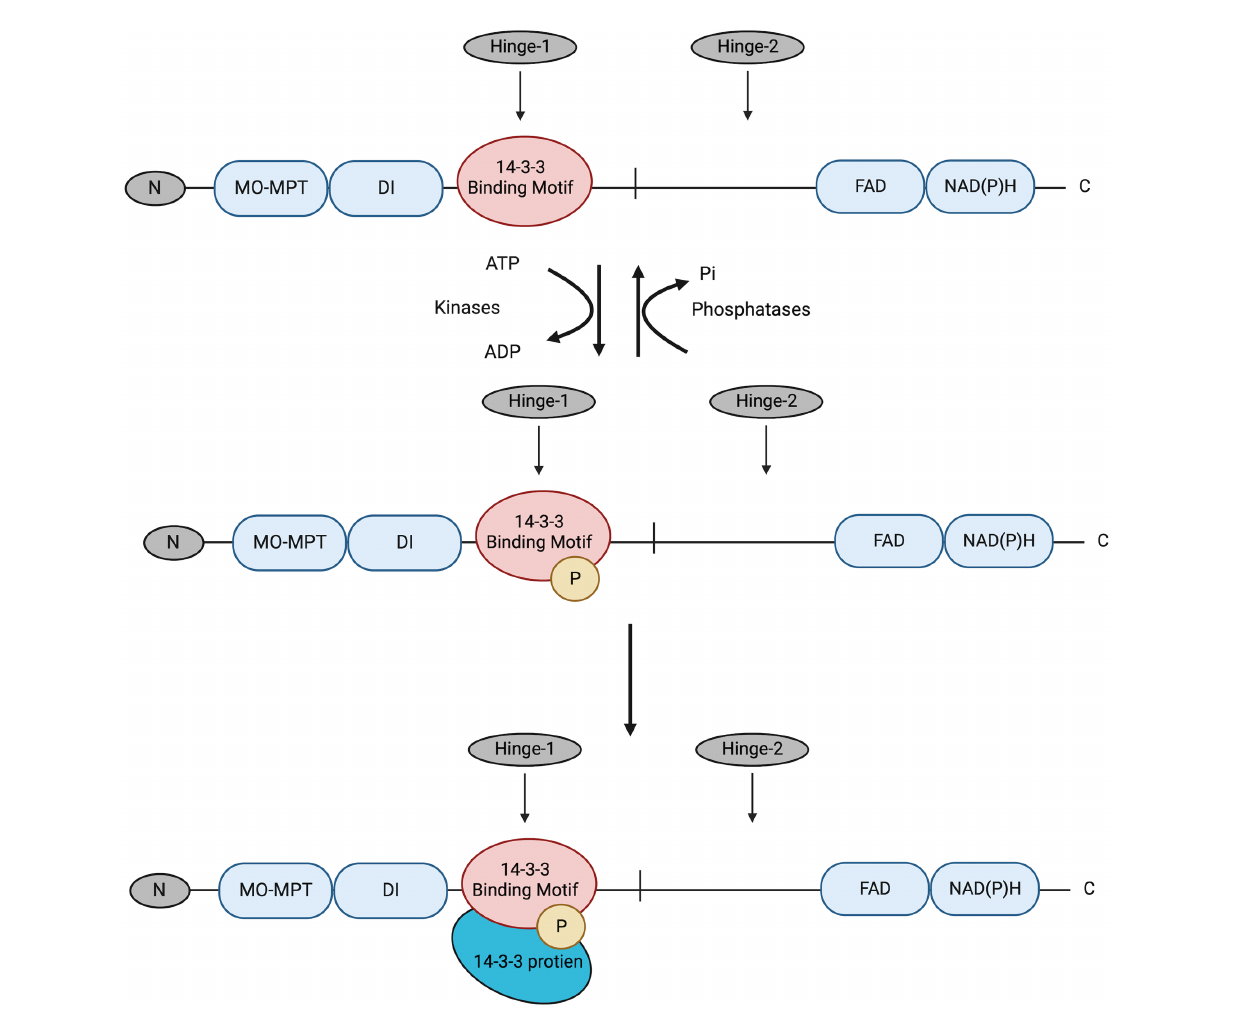
FIGURE 2 The deduced process for NR3 regulation by reversible phosphorylation and subsequent binding of putative 14-3-3 proteins. The 14-3-3 protein binding motif in the Hinge-1 region is first phosphorylated by kinases; then putative 14-3-3 proteins recognize and bind to the motif for NR3 enzyme activity regulation. This was deduced from the conserved mechanism for NR regulation by 14-3-3 proteins in higher plants (Paul et al., 2012). Pi, phosphate. The figure was created with